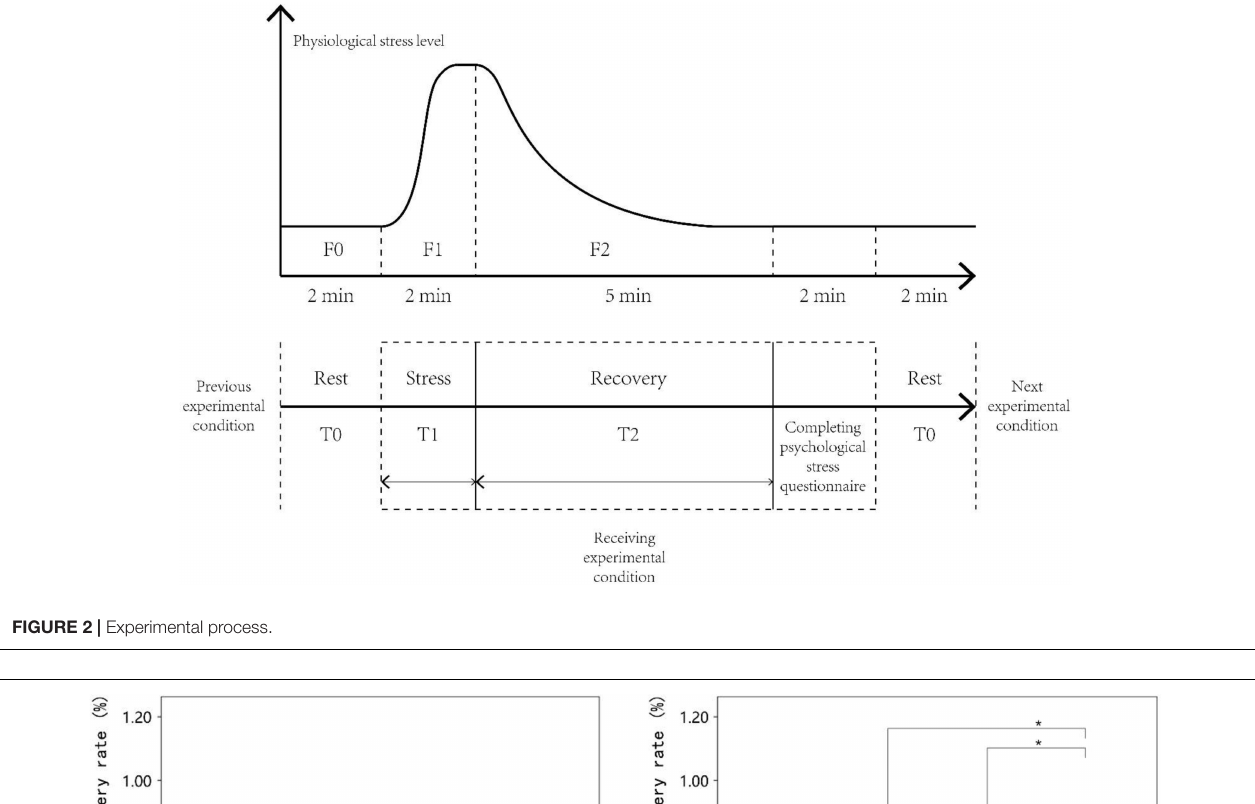
FIGURE 2 | Experimental process.